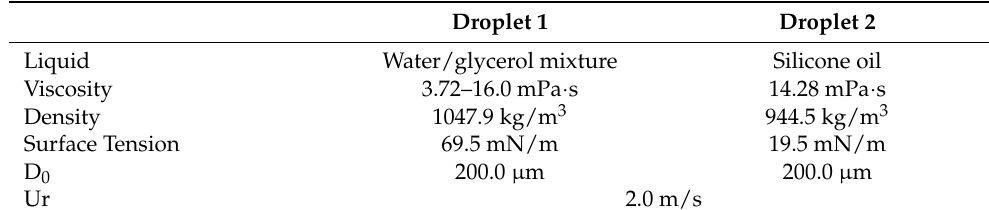
Table 3. Droplets’ physical properties and geometric parameters.